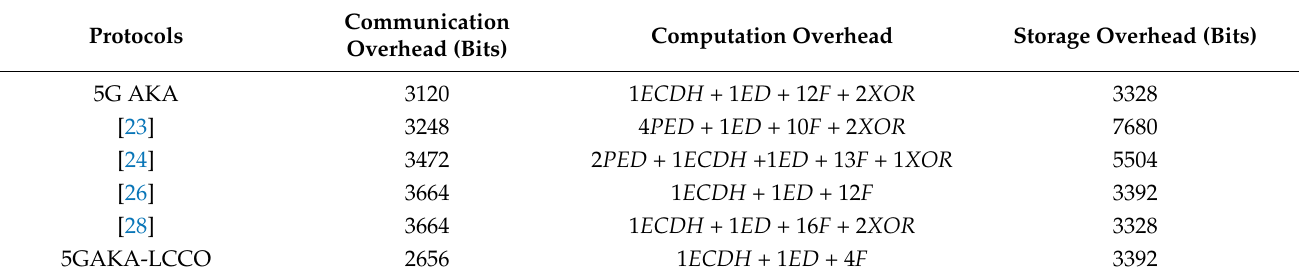
Table 3. A comparative analysis between the 5GAKA-LCCO protocol and the recently improved 5G AKA protocols [23,24,26,28] regarding the communication, computation, and storage